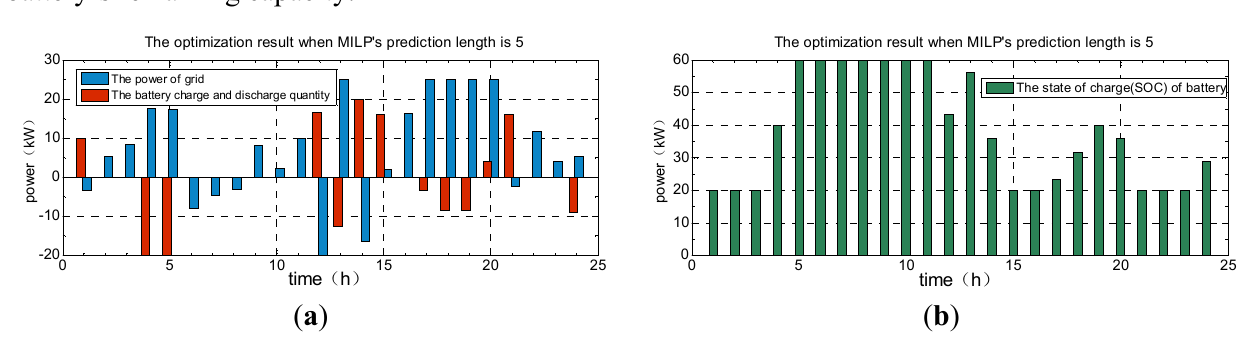
Figure 14. The optimization result when MILP’s prediction length is 5: ( a ) MILP’s receding optimization result of the grid and battery power; ( b ) MILP’s receding optimization result of the battery’s remaining